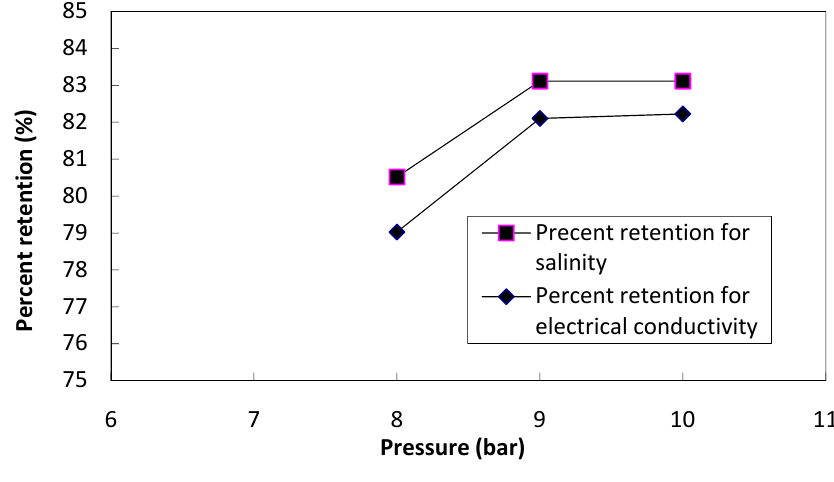
Figure 6. Retention of salinity and electrical conductivity vs . pressure for Sample 1.